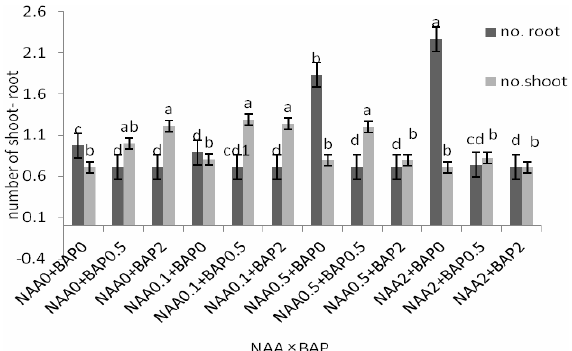
Fig. 15. The effect of combinations of NAA and BAP on shoot and root induction; Duncan’s multiple range test at